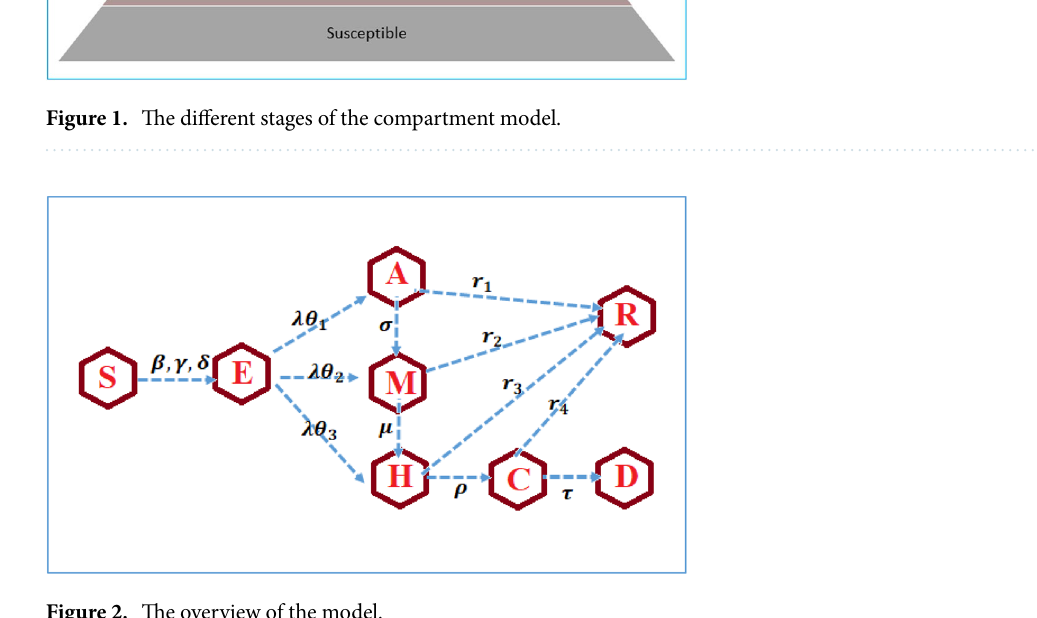
Figure 2. The overview of the